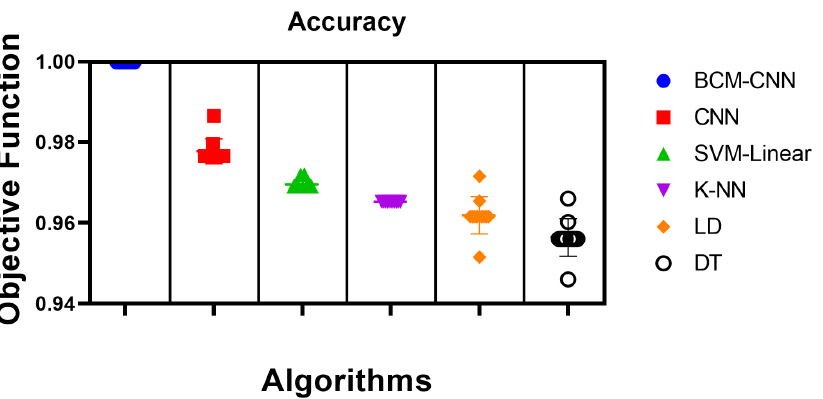
Figure 5. Box plot of accuracy for the BCM-CNN model under consideration and the contrasting models.